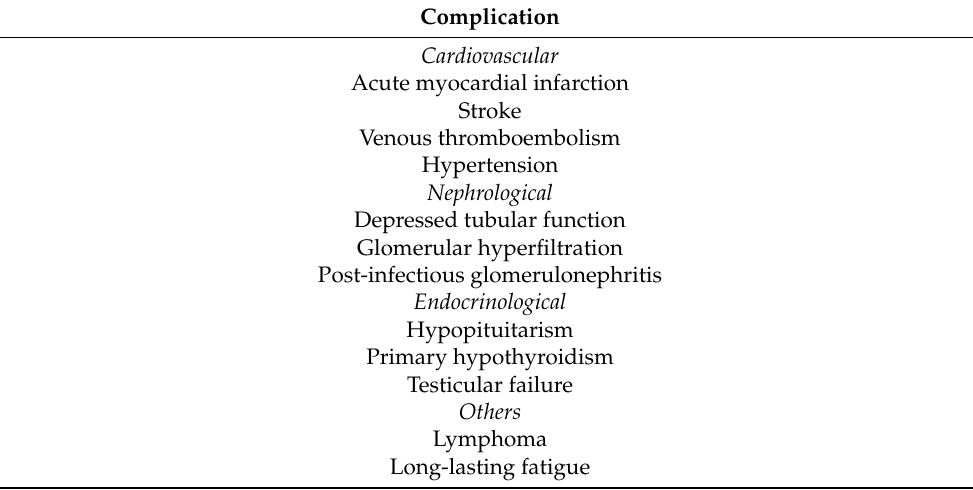
Table 2. Long-term consequences of Puumala virus